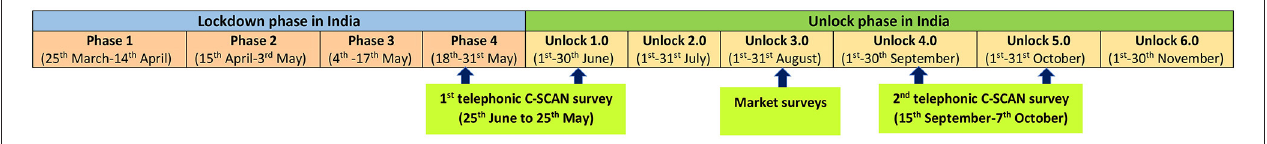
FIGURE 2 | Timeline of data collection period of C-SCAN and market